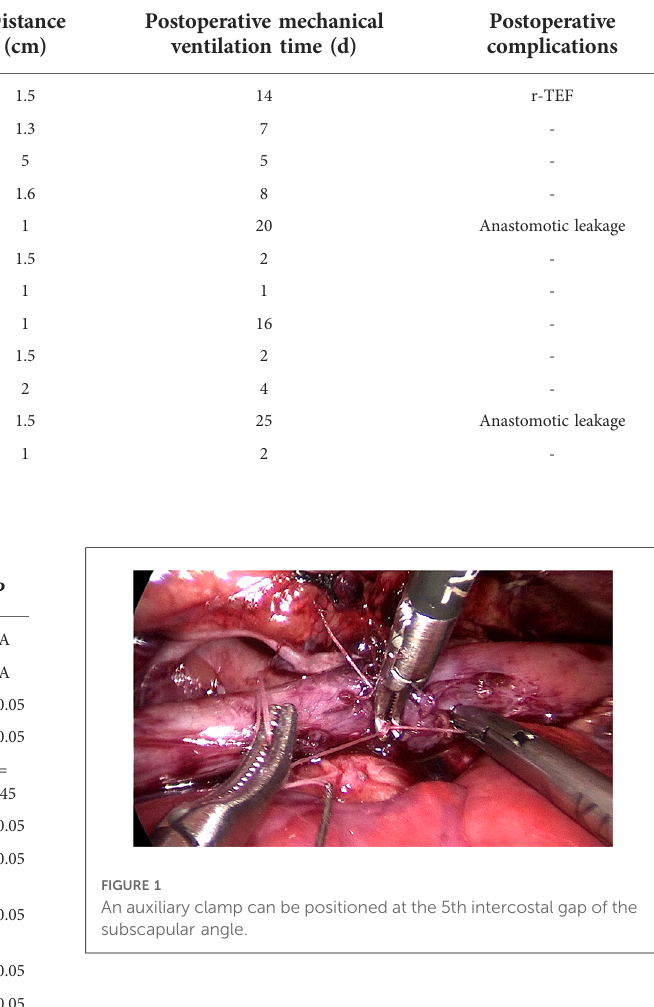
TABLE 3 Surgical